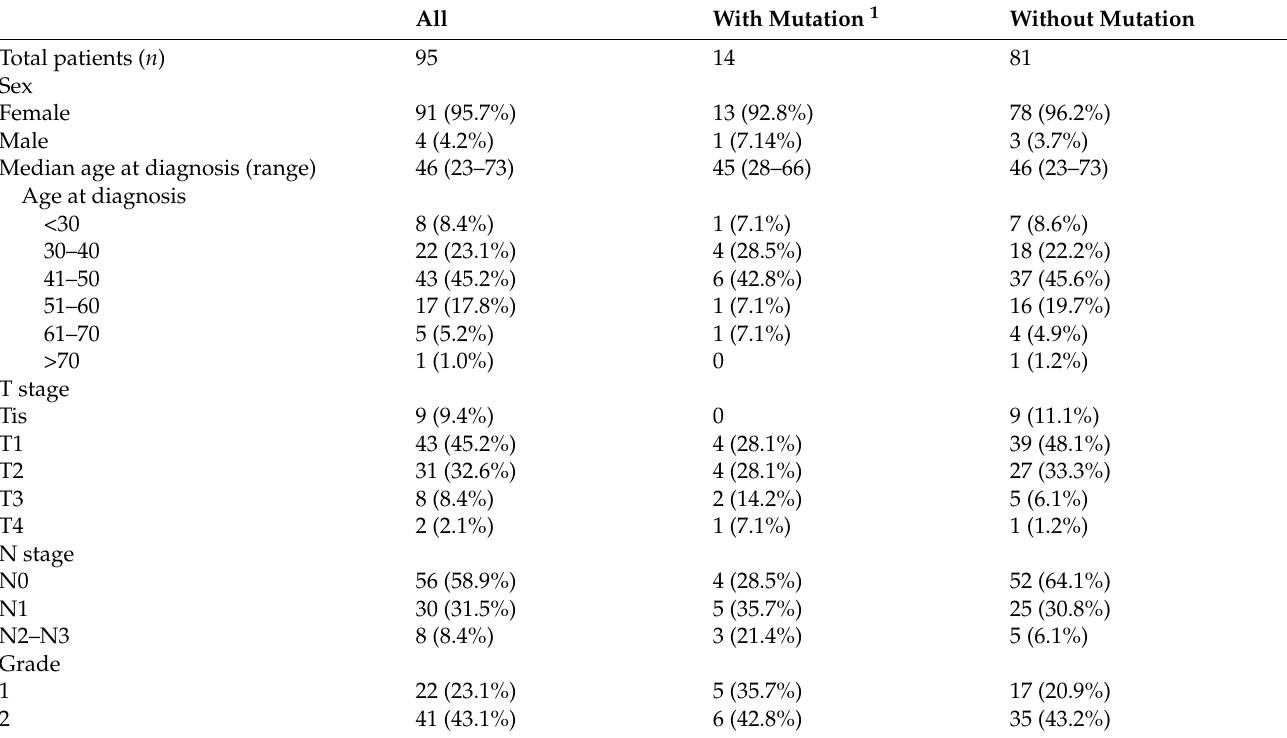
Table 1. Characteristics of study population.